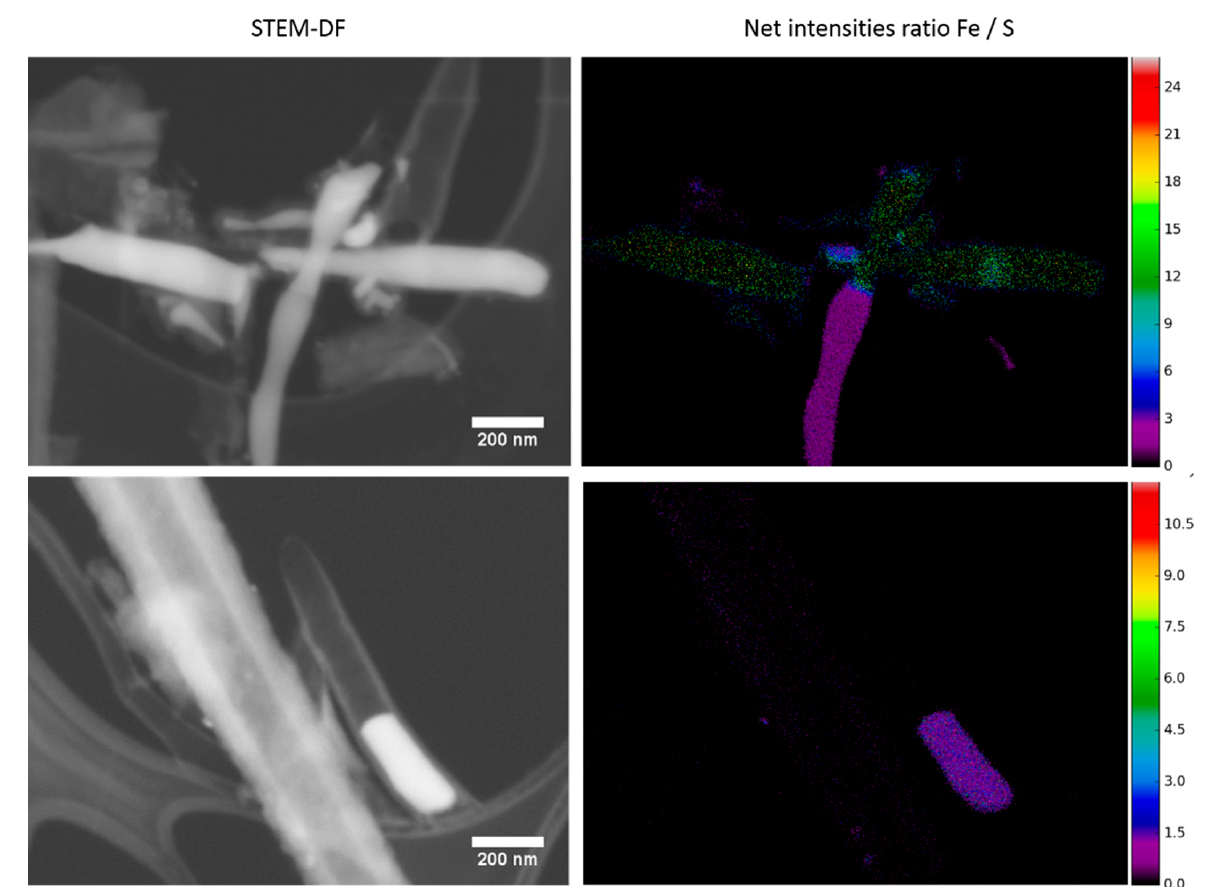
Figure 4. STEM-DF images ( left side) and net intensities Fe/S ratio maps ( right side) of the SCNA8 ( top ) and SCNA9 ( bottom ) samples at E0 = 20 kV.